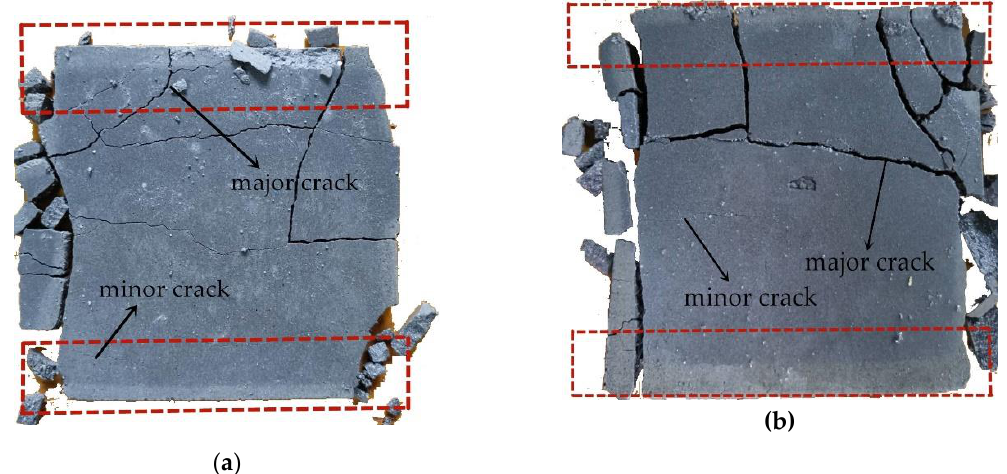
Figure 9. Cement mortar filling board inside the sample: ( a ) plate thickness of 5 mm; ( b ) plate thickness of 10 mm.